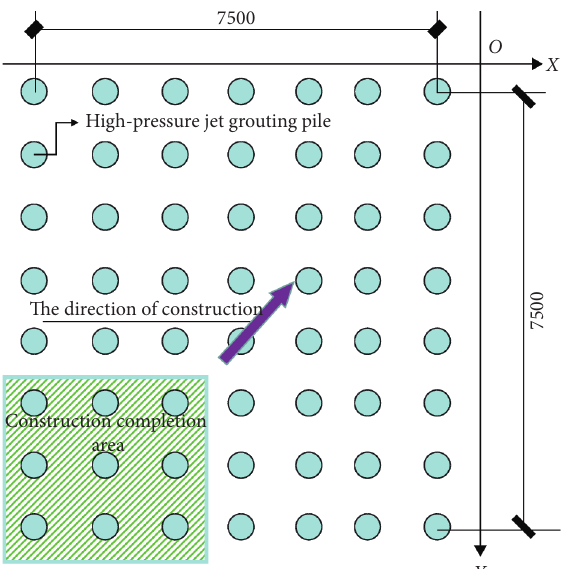
Figure 7: HPJG layout within the E slab of the biochemical pond.